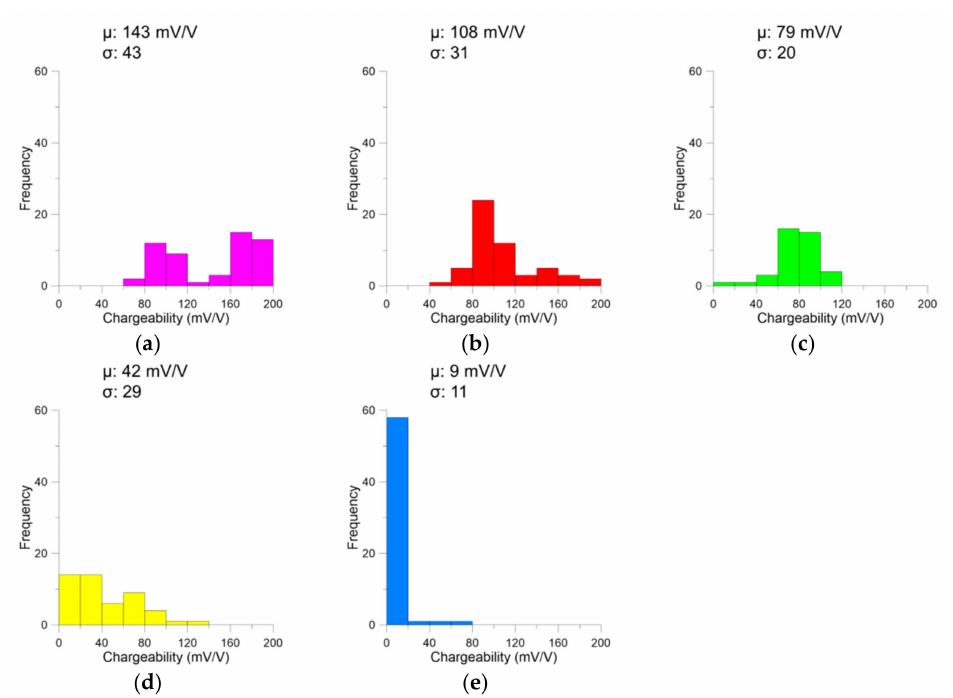
Figure 7. Histograms of chargeability of rocks including mean ( µ ) and standard deviation ( σ ) of ( a ) underground ore, ( b ) discovered ore, ( c ) gabbro, ( d ) monzodiorite, and ( e ) quartz